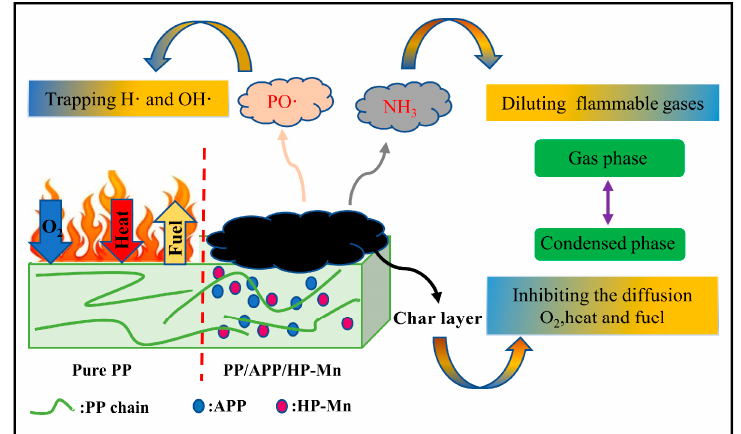
Figure 11. Schematic diagram of the flame-retardant mechanism.